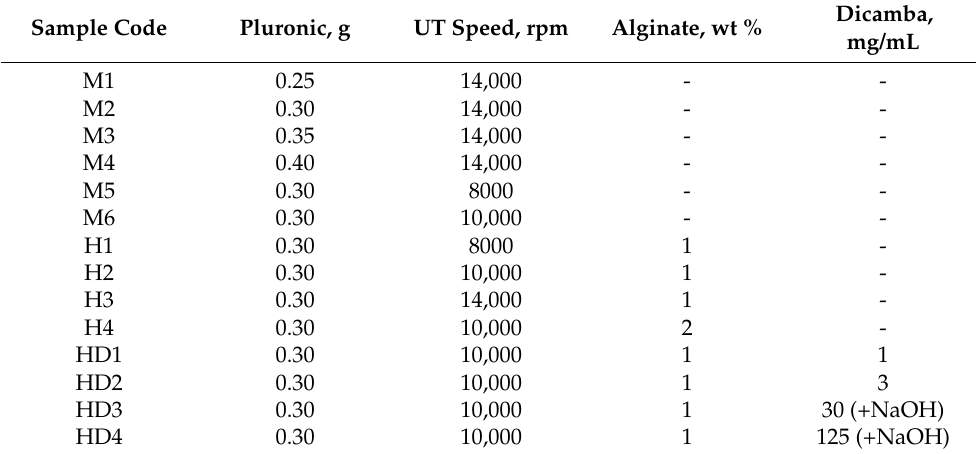
Table 1. List of formulations and operating conditions for the preparation of miniemulsions (M),